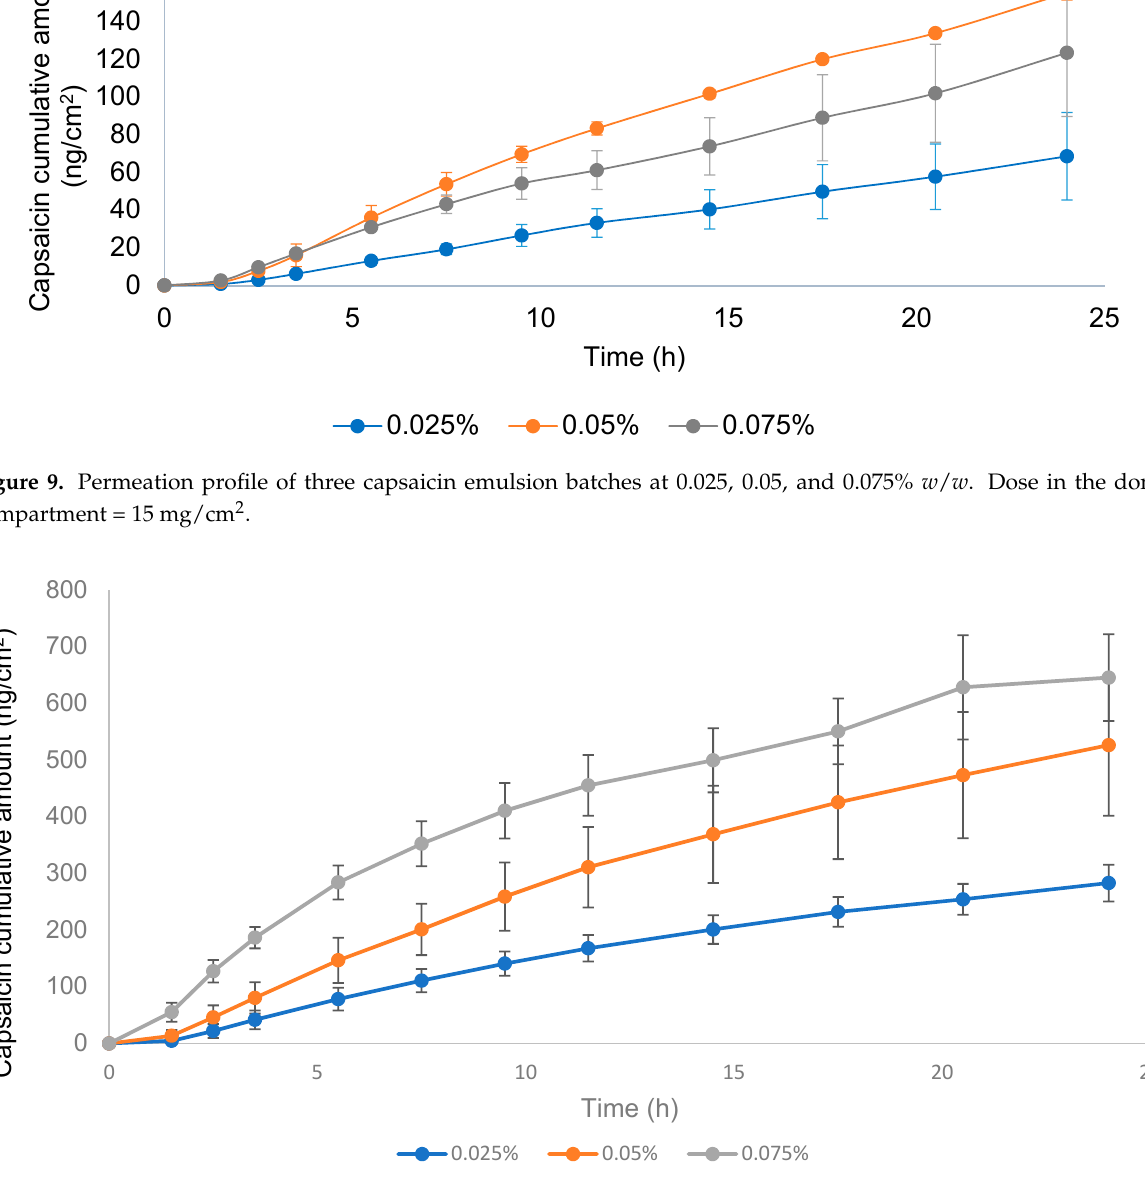
Figure 10. Permeation profile of three capsaicin emulsion batches at 0.025%, 0.05%, and 0.075% w / w . Dose in the donor compartment = 50 mg/cm 2 .